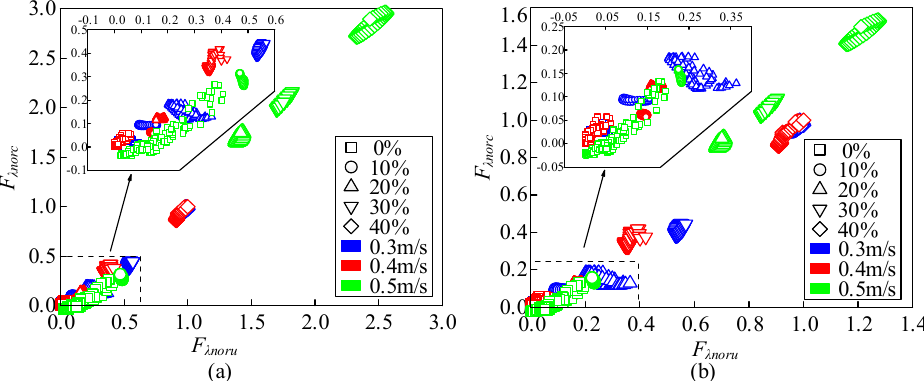
Figure 19. The distribution of the fault samples normalized by the MSN under working condition with no labeled training data: ( a ) The normalization scale corresponding to 0.3 m/s; ( b ) The normalization scale corresponding to 0.4 m/s.